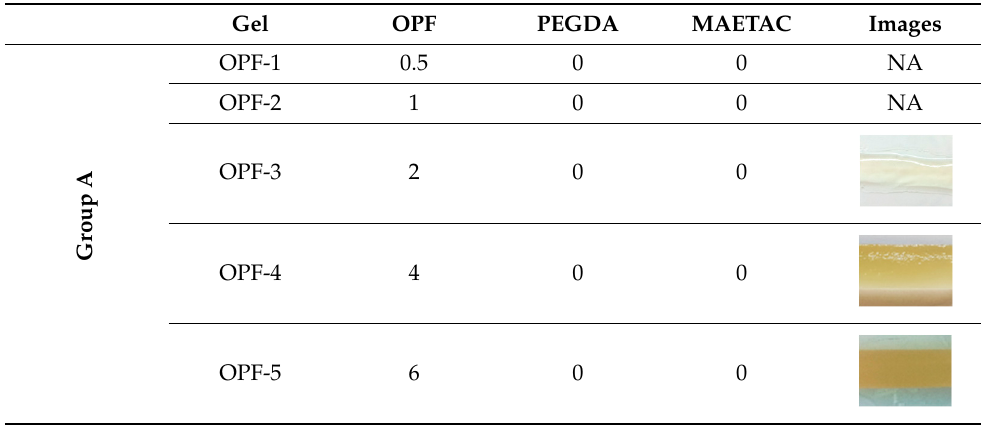
Table 1. Mass content of constituents (wt.%) used to synthesize OPF-based cryogels and images of the obtained